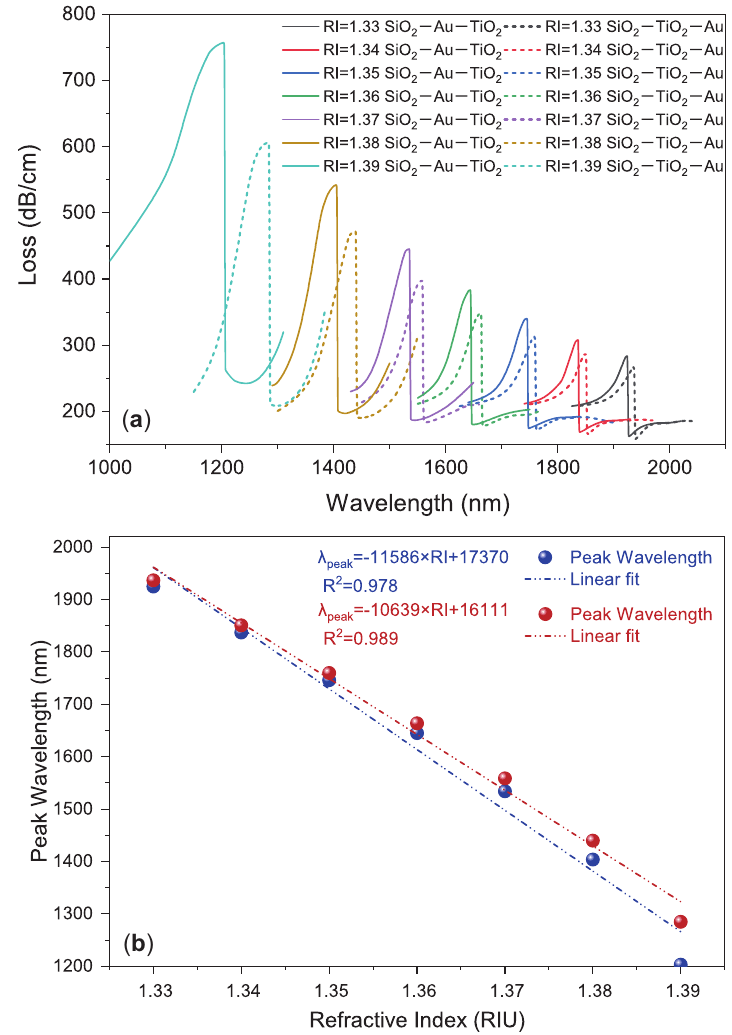
Figure 7. ( a ) The variation of loss spectrum of two heterostructures with respect to the change of the analyte’s RI. ( b ) The wavelength sensitivities to analyte’s RI for S1 and S2 heterostructures.